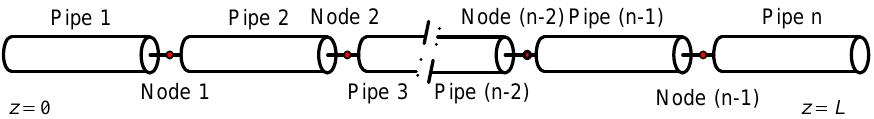
Figure A2. The numbering of the nodes and the segments for the cascaded pipeline.